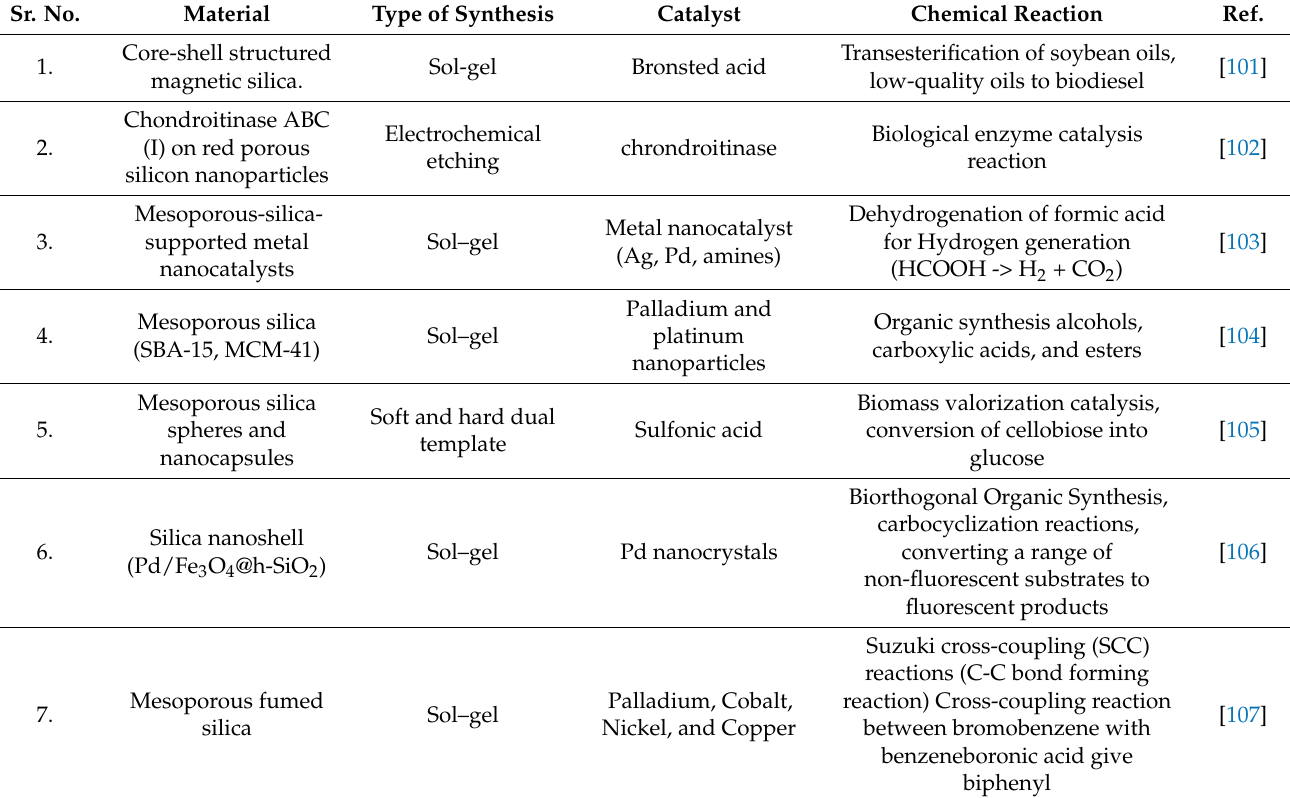
Table 3. Summary of the latest reports from the literature about the use of porous silica-based catalyst supports. Sr. No. Type of Synthesis Catalyst Chemical Reaction